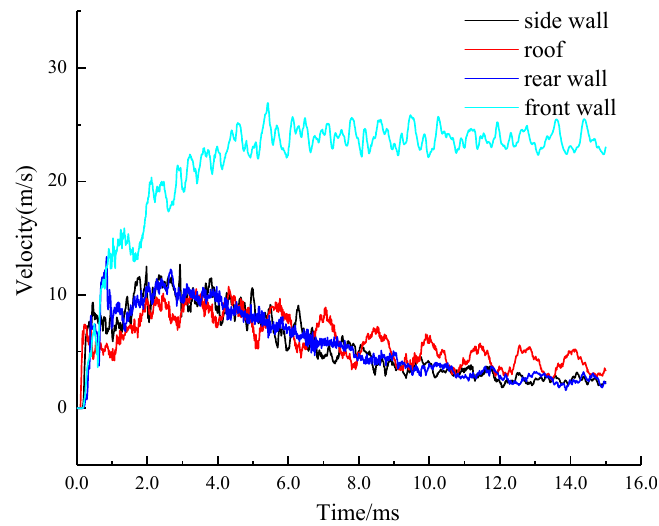
Figure 22. Launch velocity of concrete fragments.